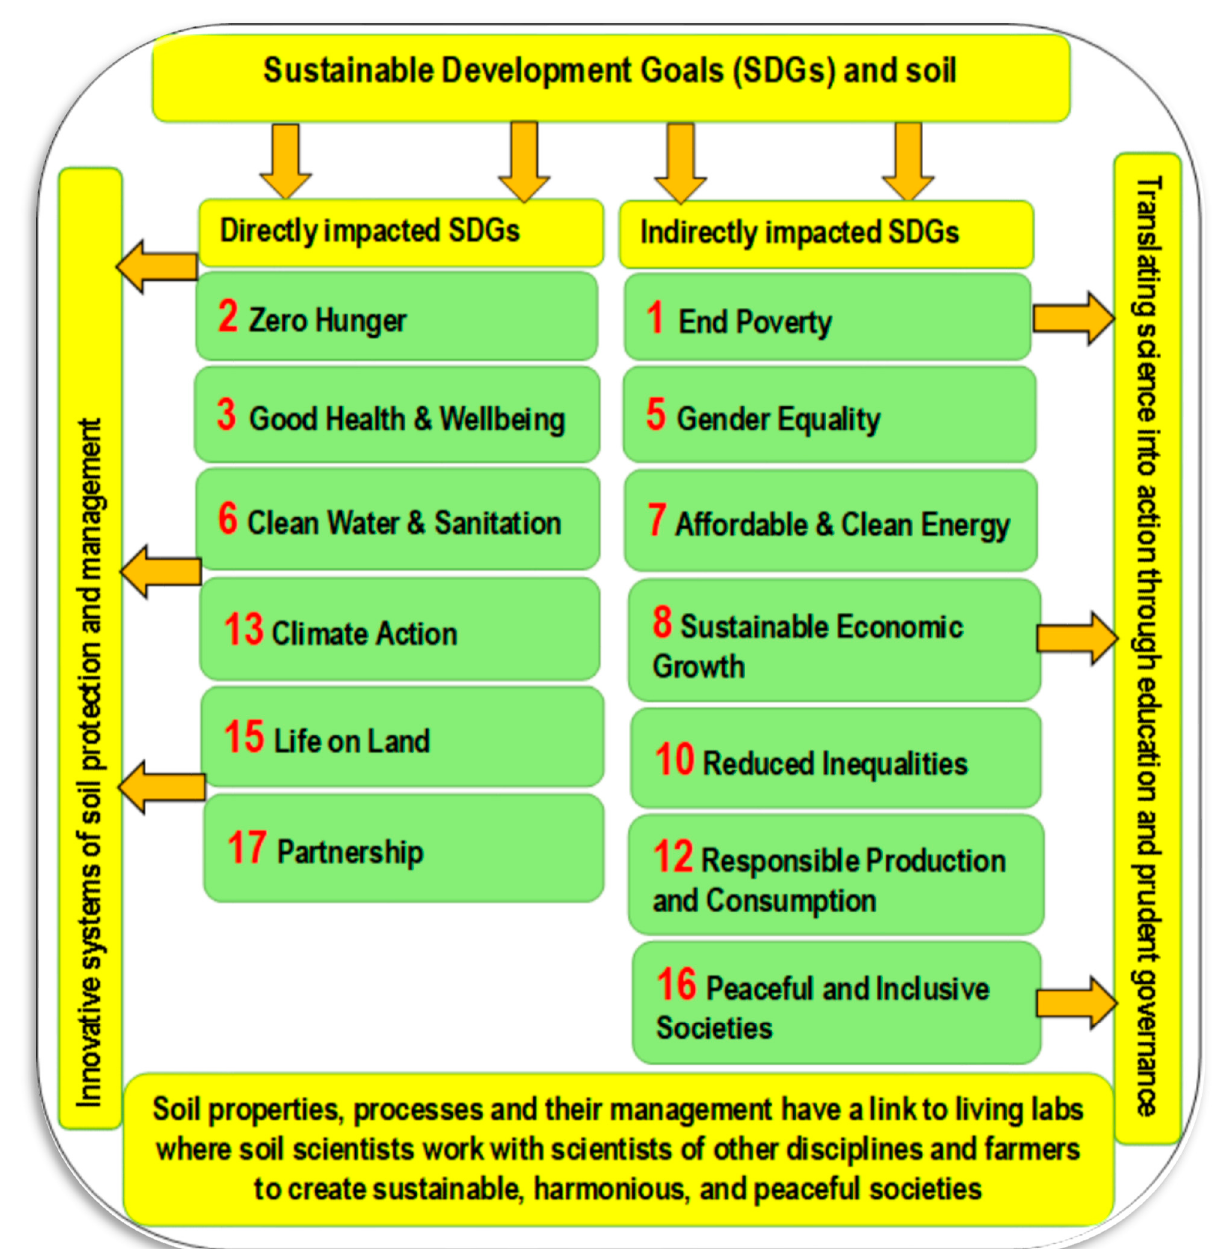
Figure 1. Sustainable Development Goals and their relationships with soil management (Sources: Lal et al. [32]).